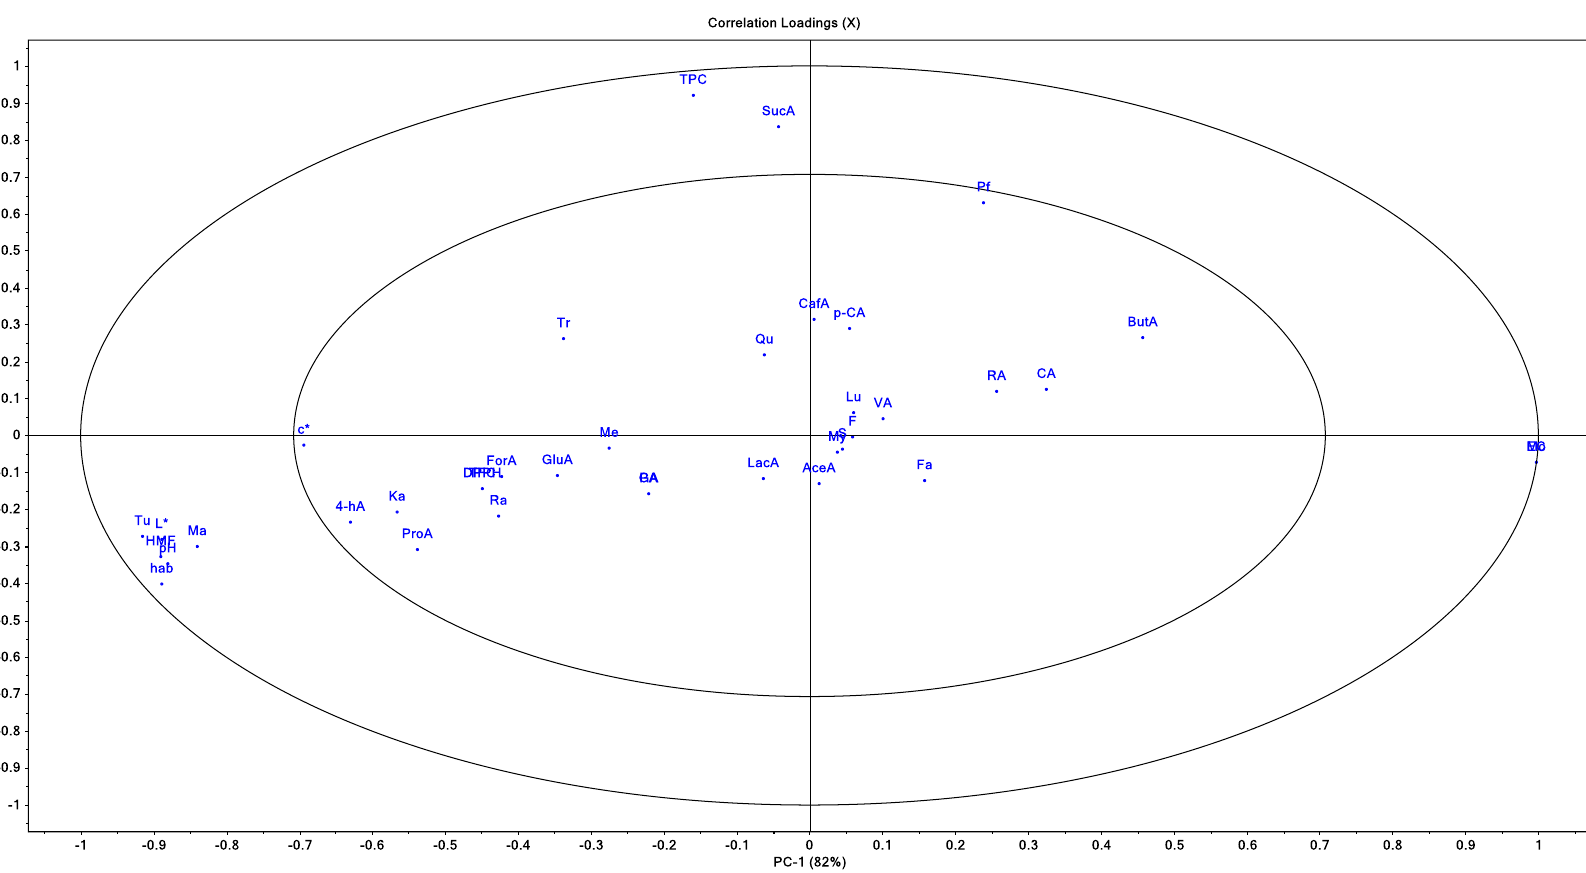
Figure 2. Principal component analysis—loadings: L*, h* ab , c* ab , Pf—Pfund color, pH, Fa—free acidity, EC—electrical conductivity, Mo—moisture, HMF, TPC—